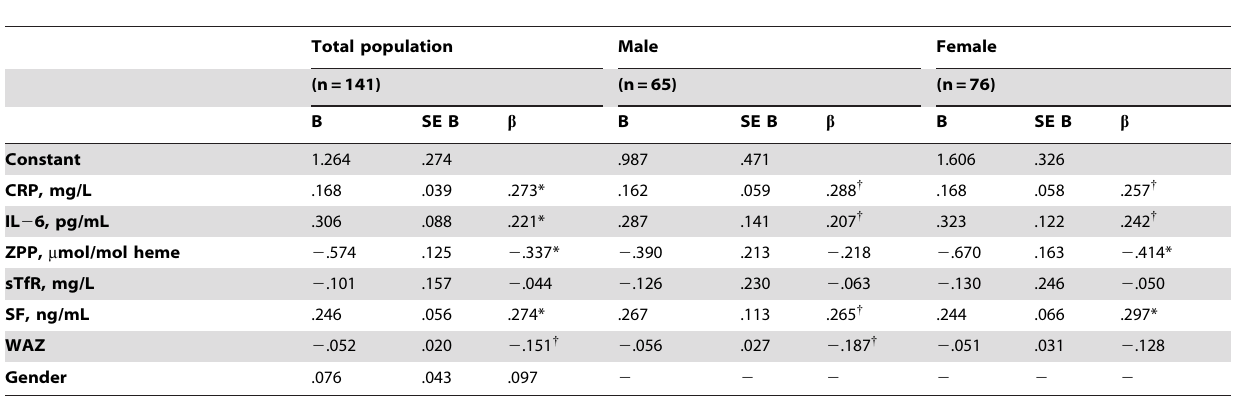
Table 3. Results of linear regression analyses for serum hepcidin (ng/mL) in the total population and by gender separately.